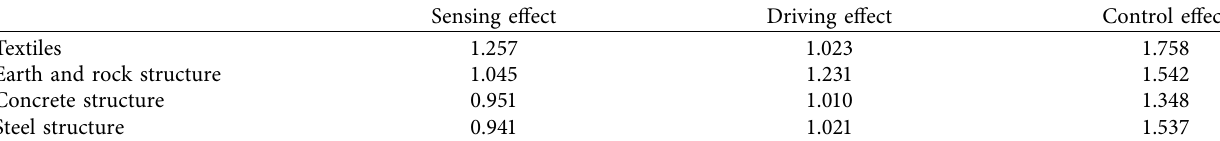
Table 3: The role of different materials.